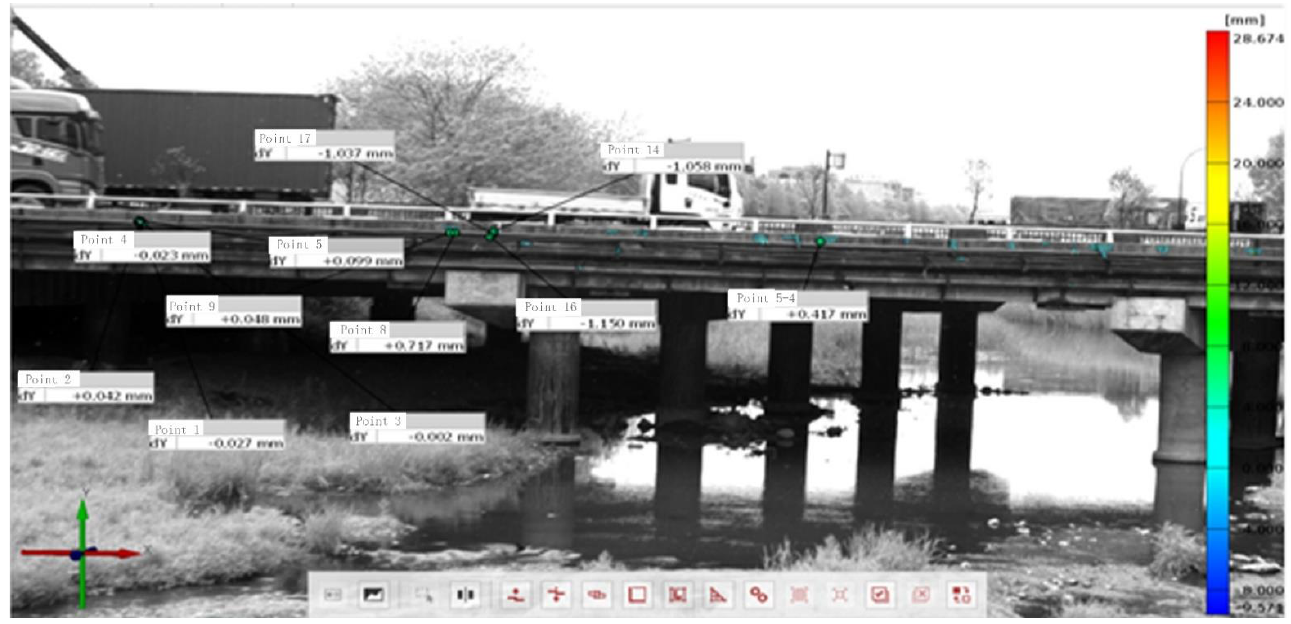
Figure 8. Interface of the monitoring system.